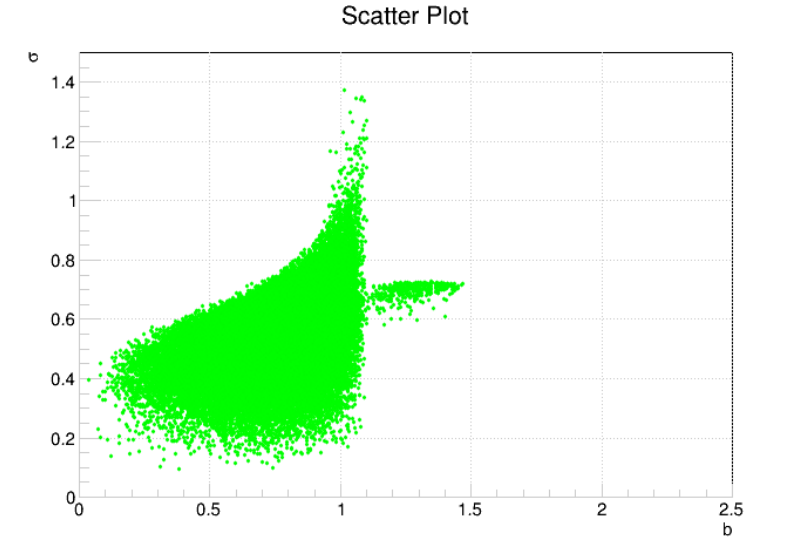
Figure 3 . Solution space in the (cid:27) (cid:0) b